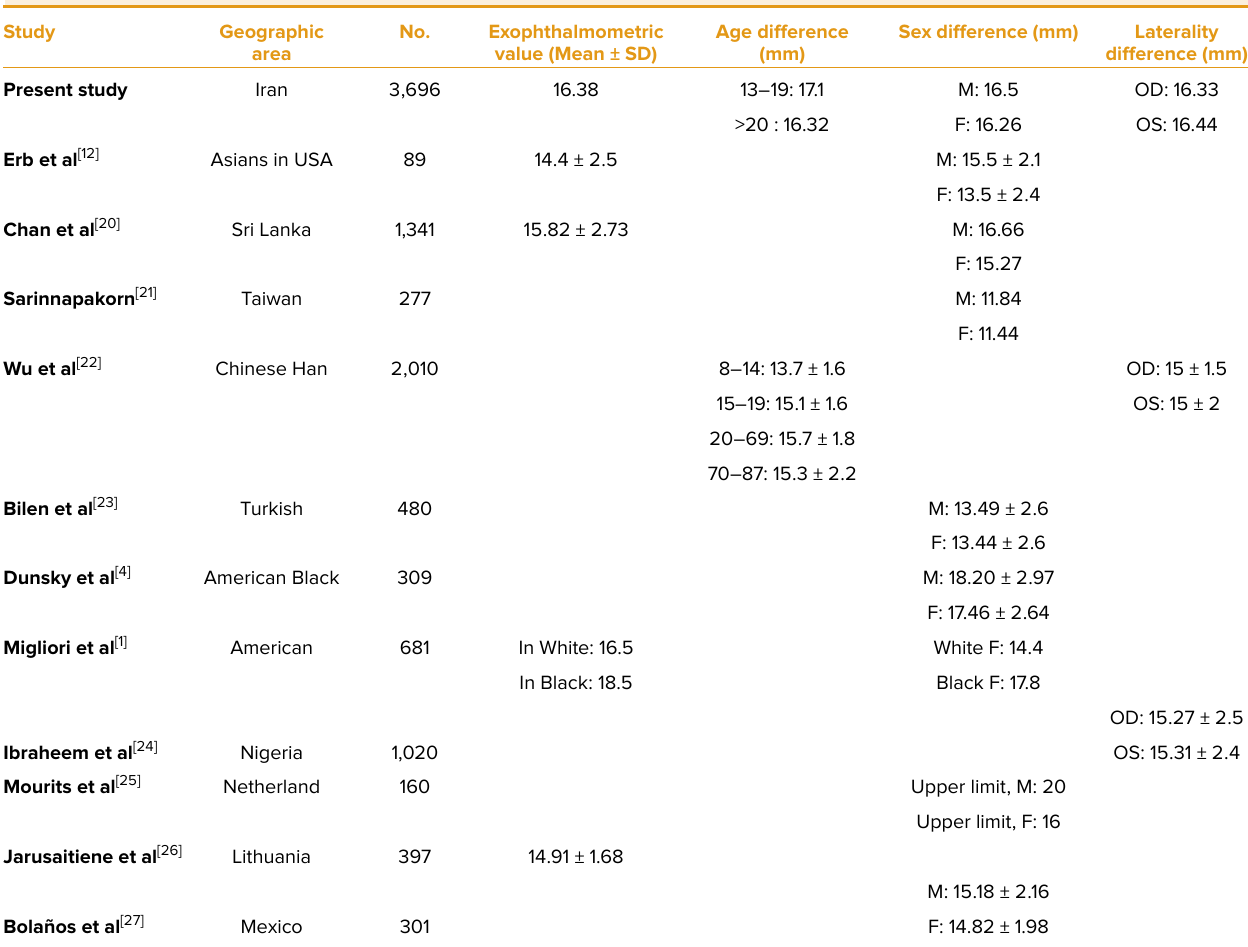
Table 3. Comparison of normal eye protrusion values in different ethnic groups